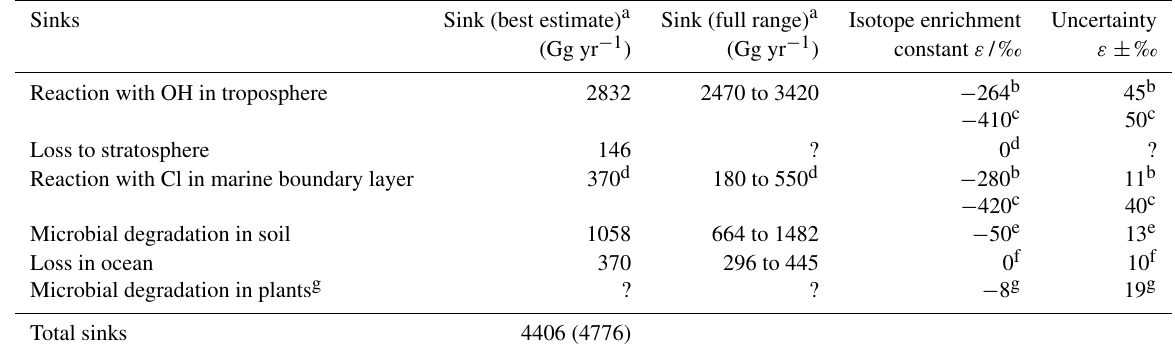
Table 3. Known sinks of tropospheric CH 3 Cl and the mean isotope enrichment constant ε reported for each. Sinks Sink (best estimate) a Sink (full range) a Isotope enrichment Uncertainty (Gg yr − 1 ) (Gg yr − 1 ) constant ε /‰ ε ± ‰ Reaction with OH in troposphere 2832 2470 to 3420 − 264 b 45 b − 410 c 50 c Loss to stratosphere 146 ? 0 d ? Reaction with Cl in marine boundary layer 370 d 180 to 550 d − 280 b 11 b − 420 c 40 c Microbial degradation in soil 1058 664 to 1482 − 50 e 13 e Loss in ocean 370 296 to 445 0 f 10 f Microbial degradation in plants g ? ? − 8 g 19 g Total sinks 4406 (4776) a Values for sink strength (best estimate and full range) were taken from Carpenter and Reimann (2014), except for the value of the reaction with Cl radicals in marine boundary layer and for total sinks shown in parentheses which includes the potential sink strength by Cl radicals in marine boundary layer (Montzka and